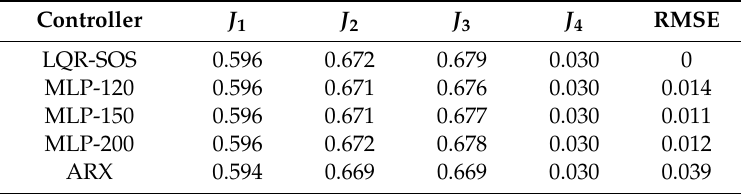
Table 8. Comparison of each controller in terms of the average performance.